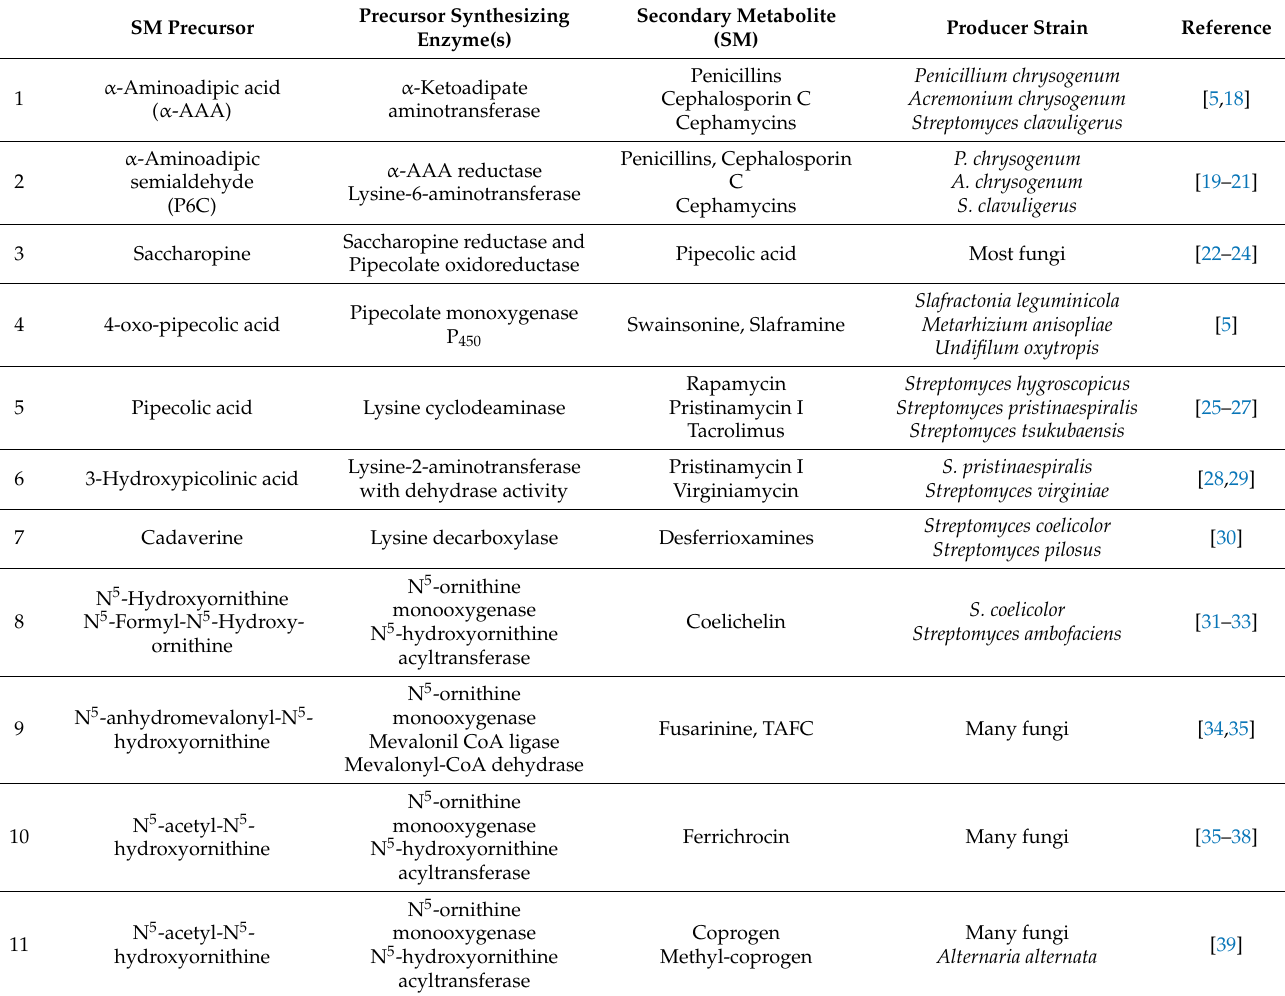
Table 1. Compounds derived from lysine or ornithine that are precursors of secondary